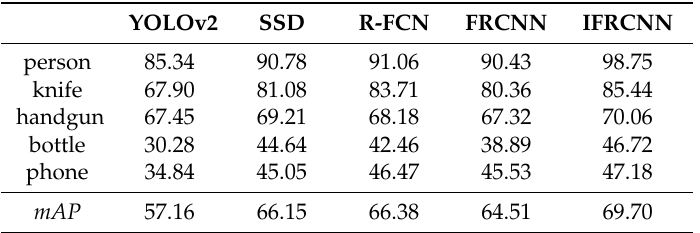
Table 4. Detection average precision (%) with different